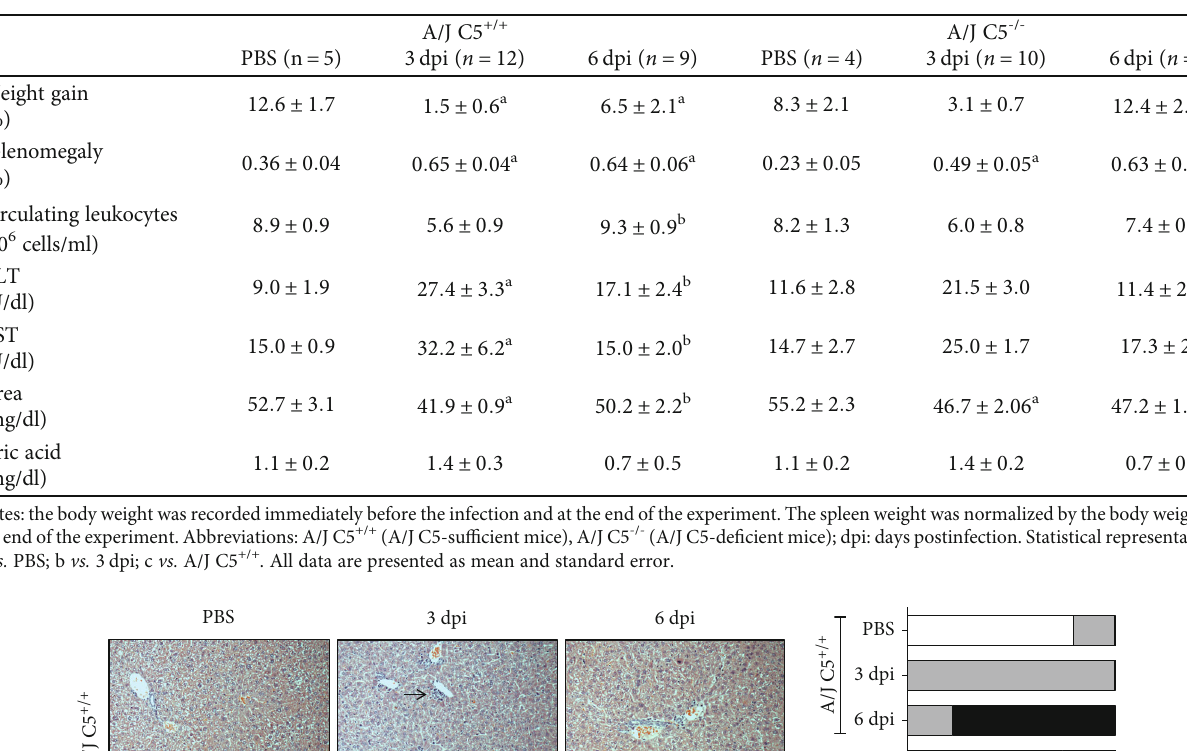
Table 1: Physiological pro fi le of A/J mouse strain infected by LPF.